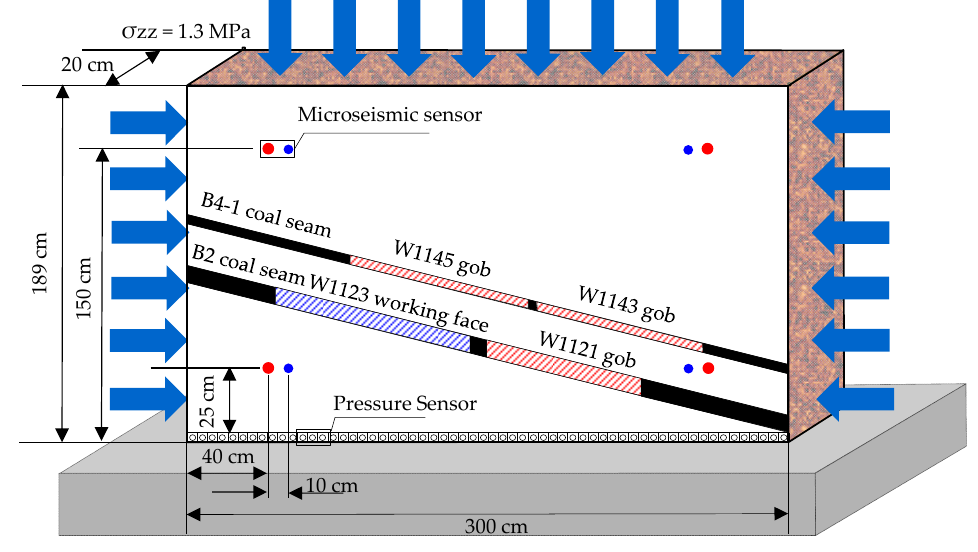
Figure 7. Model design.